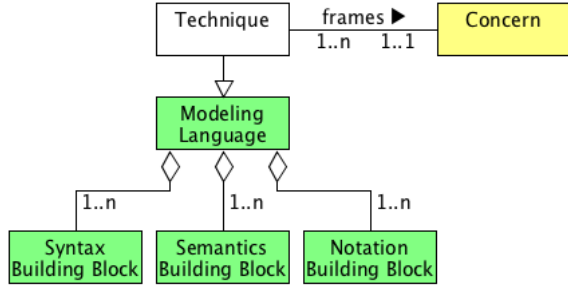
Figure 4. Conceptualization of the